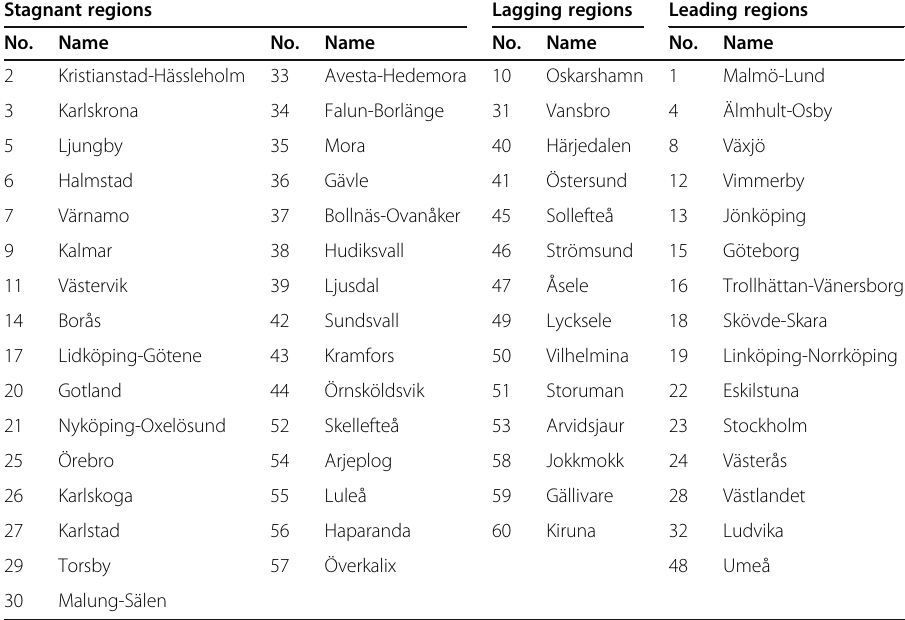
Table 10 Classification ( k -means clustering) of Swedish functional analysis regions according to change in nominal GRP and population between 2010 and